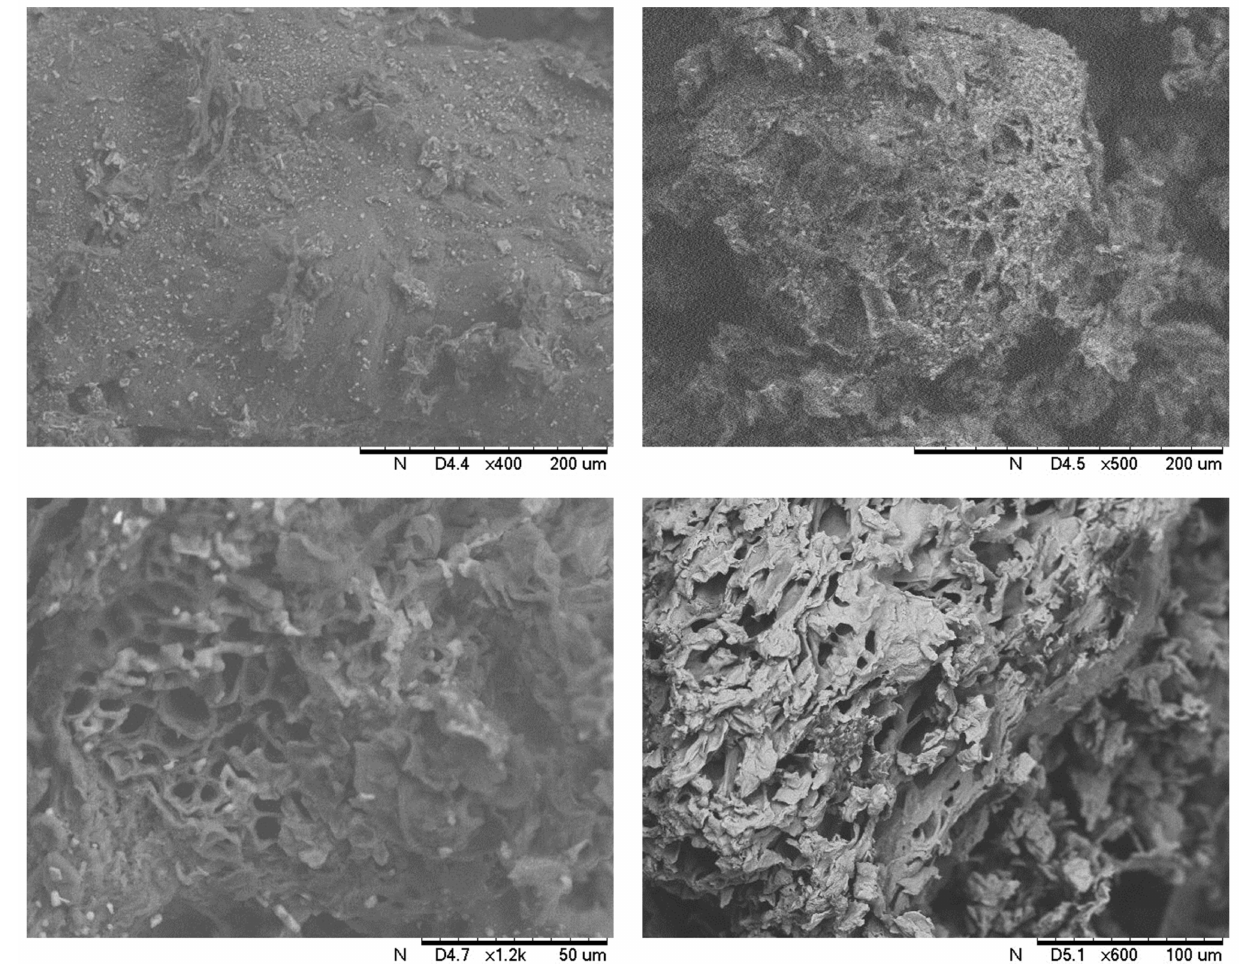
Figure 8. Recording of the microstructural characteristics of fresh